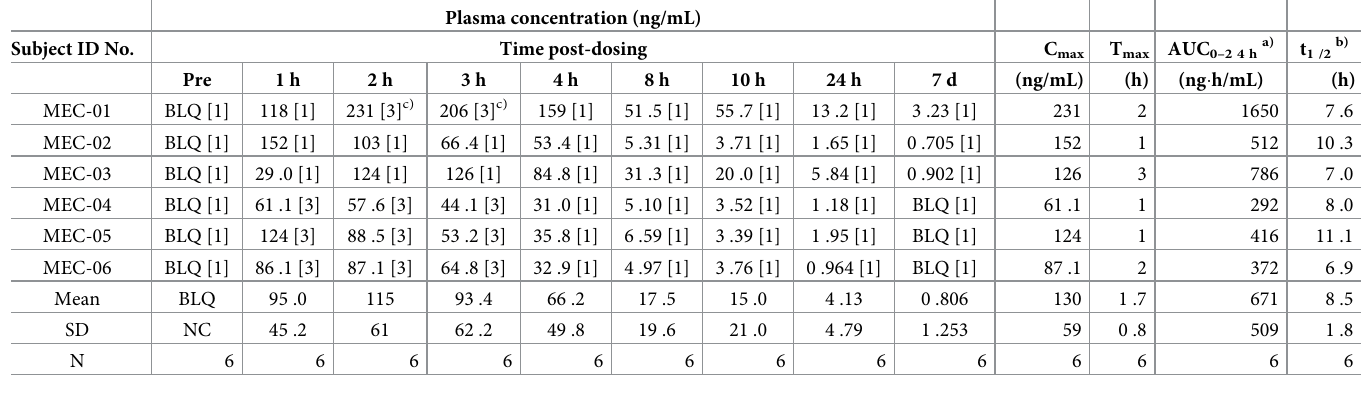
Table 2. Plasma concentrations and pharmacokinetic parameters of meclizine in achondroplasia children after single oral administration of meclizine hydrochlo- ride 25 mg tablet.